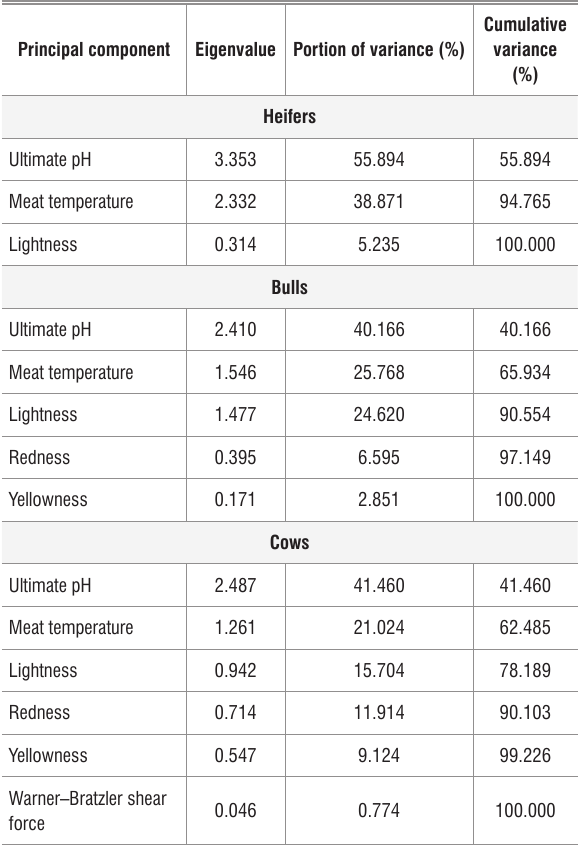
Contribution of the principal components to the total variance of beef quality by animal class